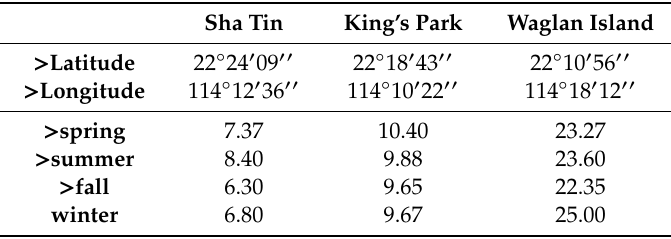
Table 2. The seasonal surface horizontal wind speed (unit: m / s) at the Hong Kong Observatory automatic weather stations: Sha Tin, King’s Park and Waglan Island. The data was extracted from https: // www.hko.gov.hk / en / cis / climat.htm on 7 Mar. 2020. Sha Tin King’s Park Waglan